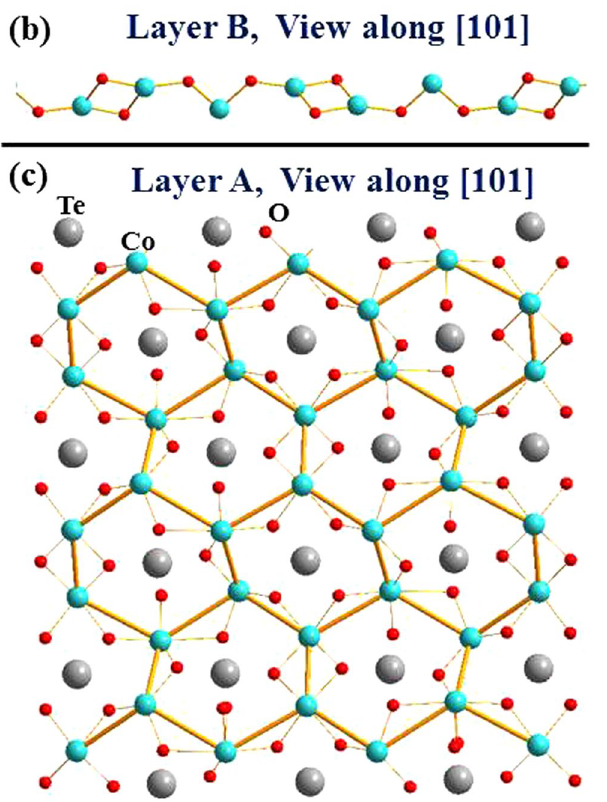
Figure 2. ( a ) Atomic arrangement of the Co ions in Layer B. The Co ions form well separated zigzag chains. ( b ) Atomic arrangement of the Co and Te ions in Layer A. The Co ions crystalize into a significantly distorted honeycomb, with the Te ions occupying the